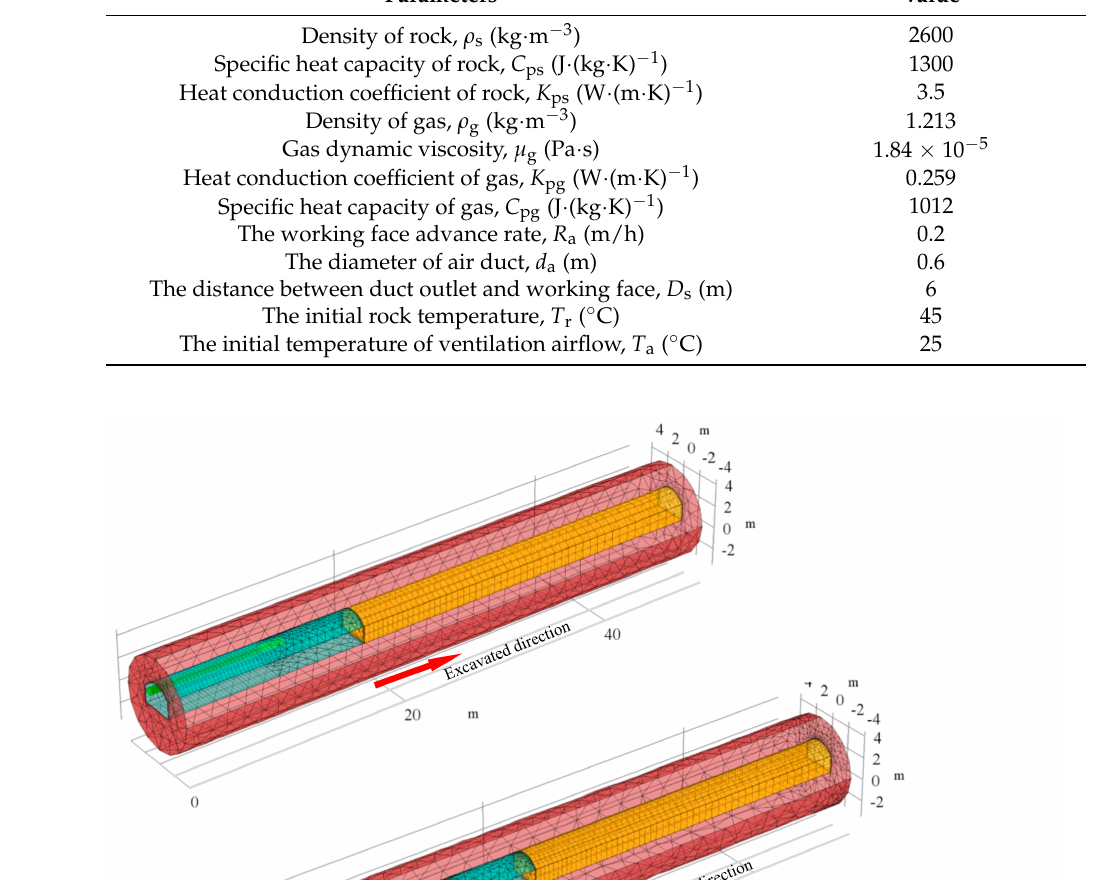
Table 1. Parameters used in the numerical simulation. Parameters